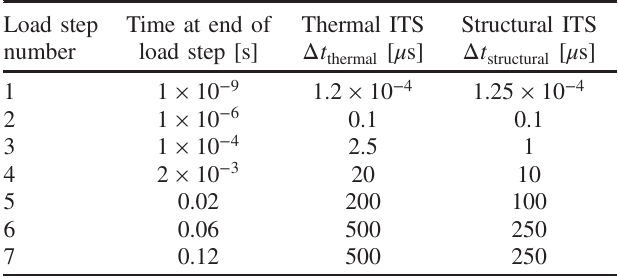
TABLE II. Load step sequences used for FEM thermal and structural analyses. ITS stands for integration time step. The first load step represents the beam impact. The computational time needed to achieve these structural integration time steps for one simulation is very significant ( ∼ 3 weeks on a 32 GB RAM 4-core machine with a processor speed of 4.00